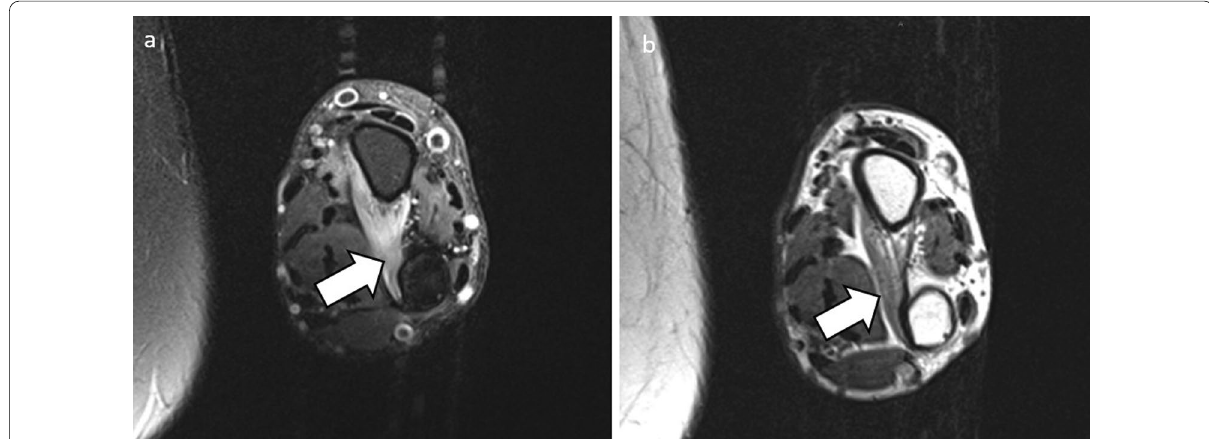
Fig. 13 50-year-old male with flexor pollicis longus palsy. Axial PDFS ( a ) and PD ( b ) at the level of the distal forearm demonstrate atrophy and denervation oedema of the pronator quadratus (white arrows), supportive of anterior interosseous nerve (AIN) denervation. A discrete lesion or compressive cause has not been identified